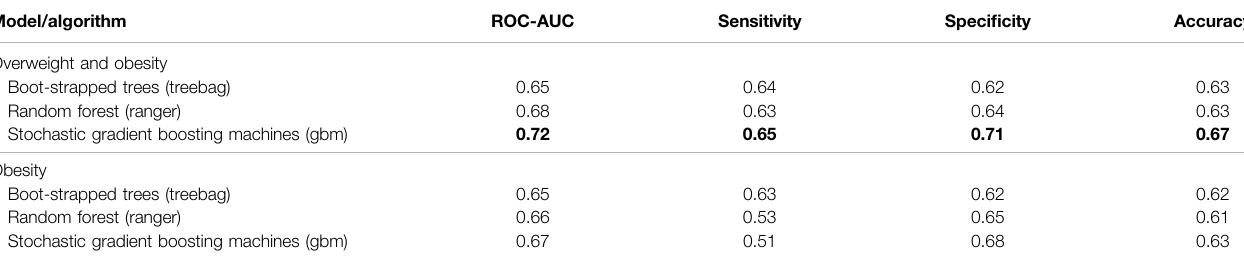
TABLE 2 | Performance metrics of overweight and obesity prediction models constructed using various machine learning algorithms in the test data set of the FOS. Model/algorithm Overweight and obesity Boot-strapped trees